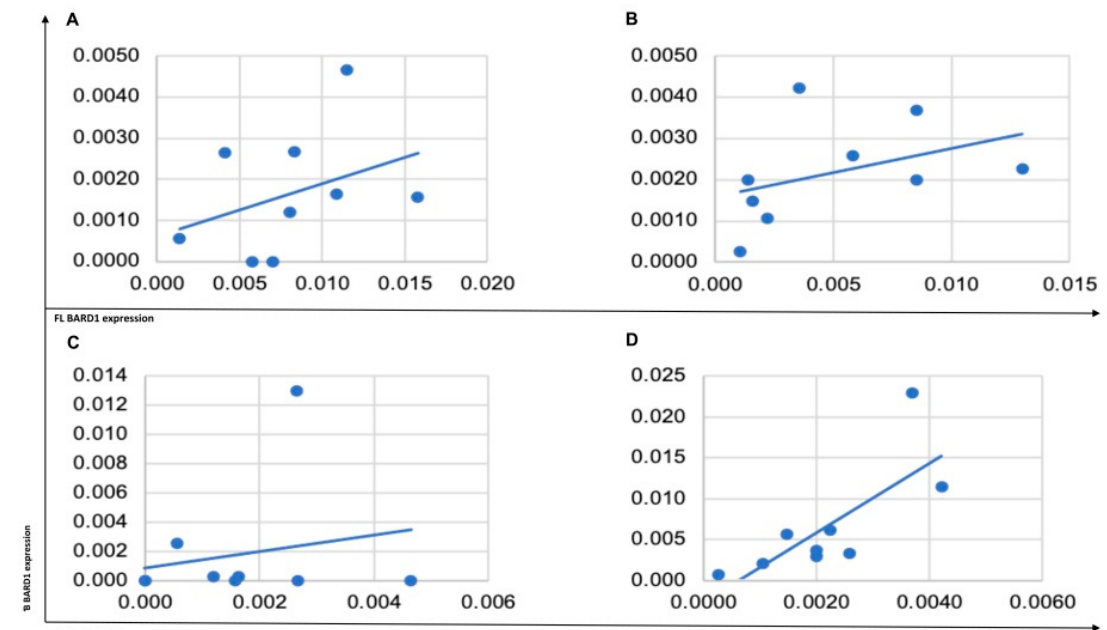
Figure 4. TERT and BARD1 isoforms expression level of yolk sac representative samples. Histogram of mRNA expression